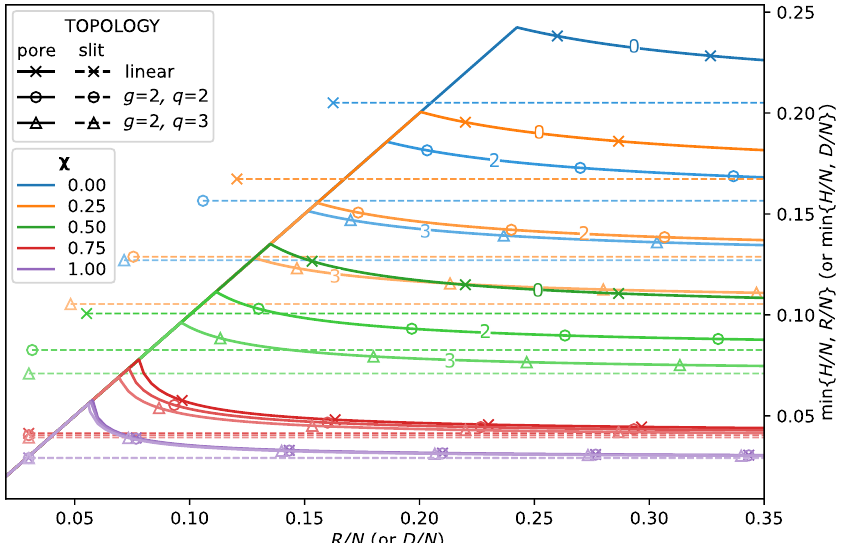
Figure 2. Normalised brush thickness, min { H / N ; R / N } , as a function of the normalised pore radius, R / N , for selected values of the χ -parameter ( 0;0.25;0.5;0.75;1.0 ) and different topologies (linear and dendritic) of the brush forming macromolecules, as indicated with ( g , q ) numbers. Horizontal dashed lines correspond to the thickness H of a brush grafted onto a planar surface. The corresponding values of χ are color-coded, and topologies are indicated with markers, where cross, circle, and square markers are linear chains and the second generation dendroids g = 2 of different branching functionalities q = 2 and q = 3, respectively. Numbers on the solid lines denote the dendron functionality q , where 0 corresponds to linear